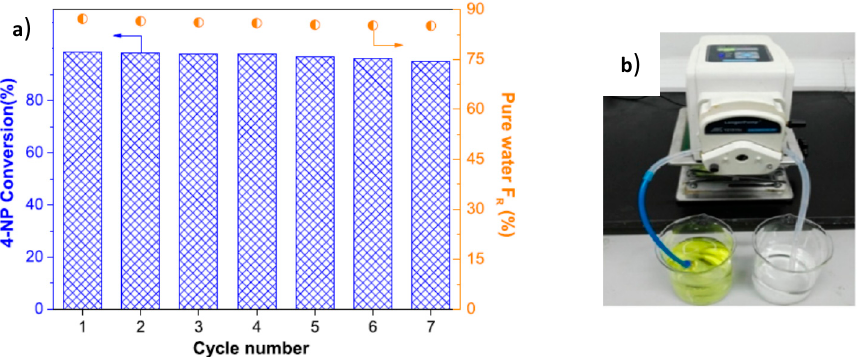
Figure 12. Conversion of 4-NP, pure water flux recovery ratio (F R ) and filtration of HA with PES/TA-AgNPs membrane ( a ) after 7 times passing through membrane type catalytic reactor ( b ). (Compiled and reprinted from [52]).